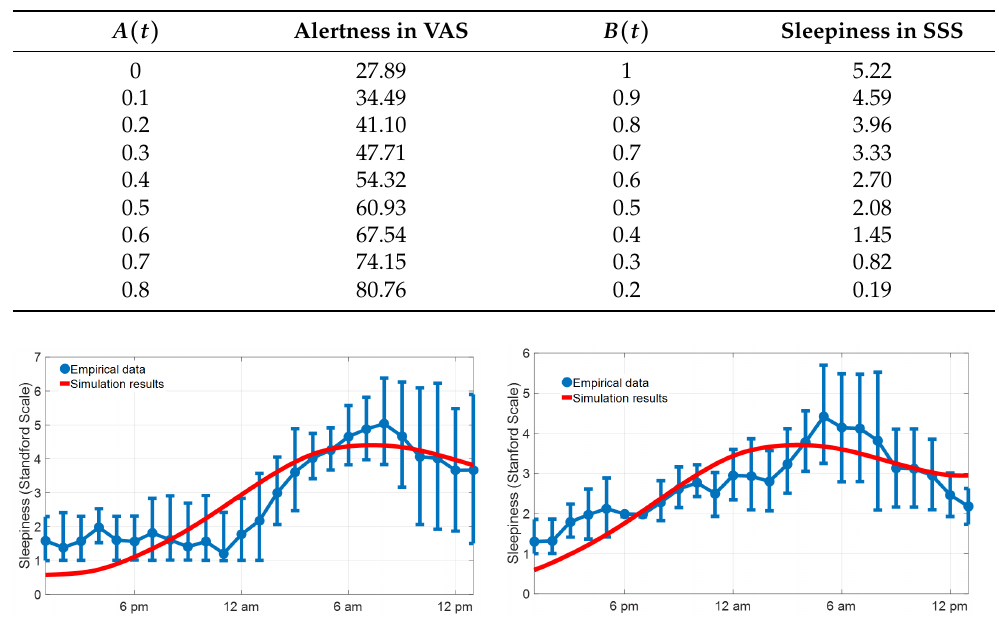
Figure 5. Comparison of simulation results and empirical data (mean ± SD) of sleepiness rating during a dim light constant routine protocol after a long ( left ) and a short ( right ) photoperiod